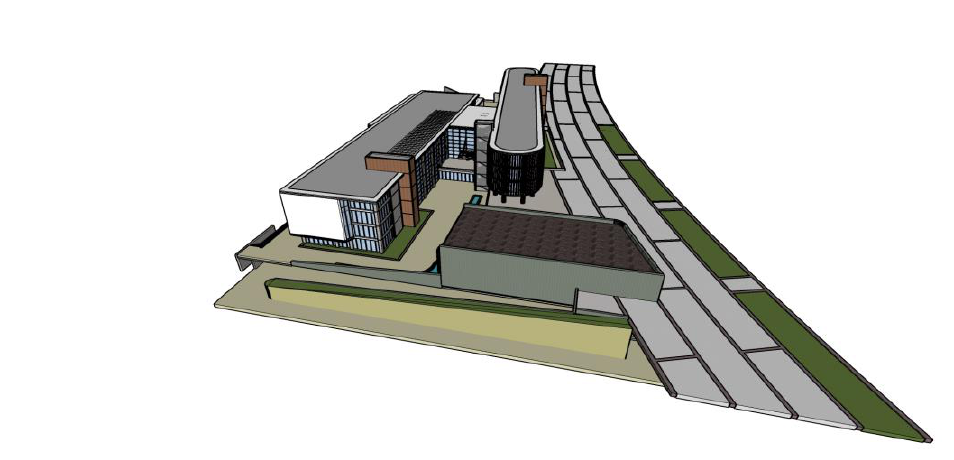
Figure 5 . CAD to BIM